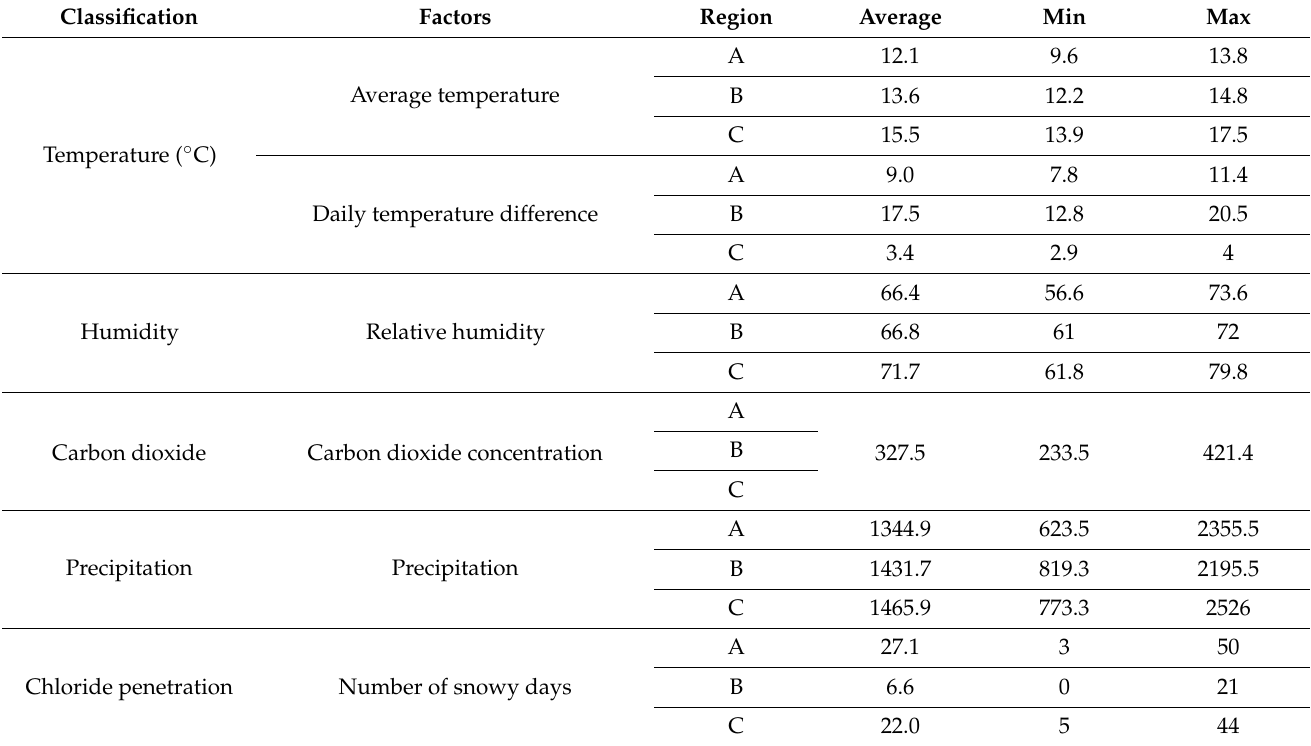
Table 3. Environmental conditions data for each